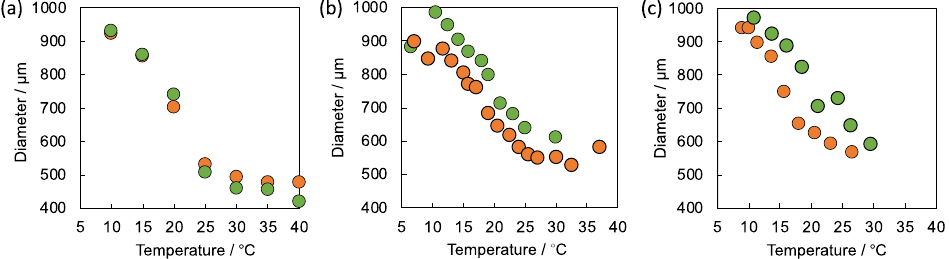
Figure 6. Equilibrium swelling behavior of ( a ) SOG-10, ( b ) SOG-20 and ( c ) SOG-30 in reduced state (orange) and oxidized state (green) at the various temperatures. The gels were equilibrated in water containing HNO 3 (894 mM) and NaBrO 3 (100 mM) for the oxidized state and in water containing HNO 3 (894 mM) and NaCl (100 mM) for the reduced state.